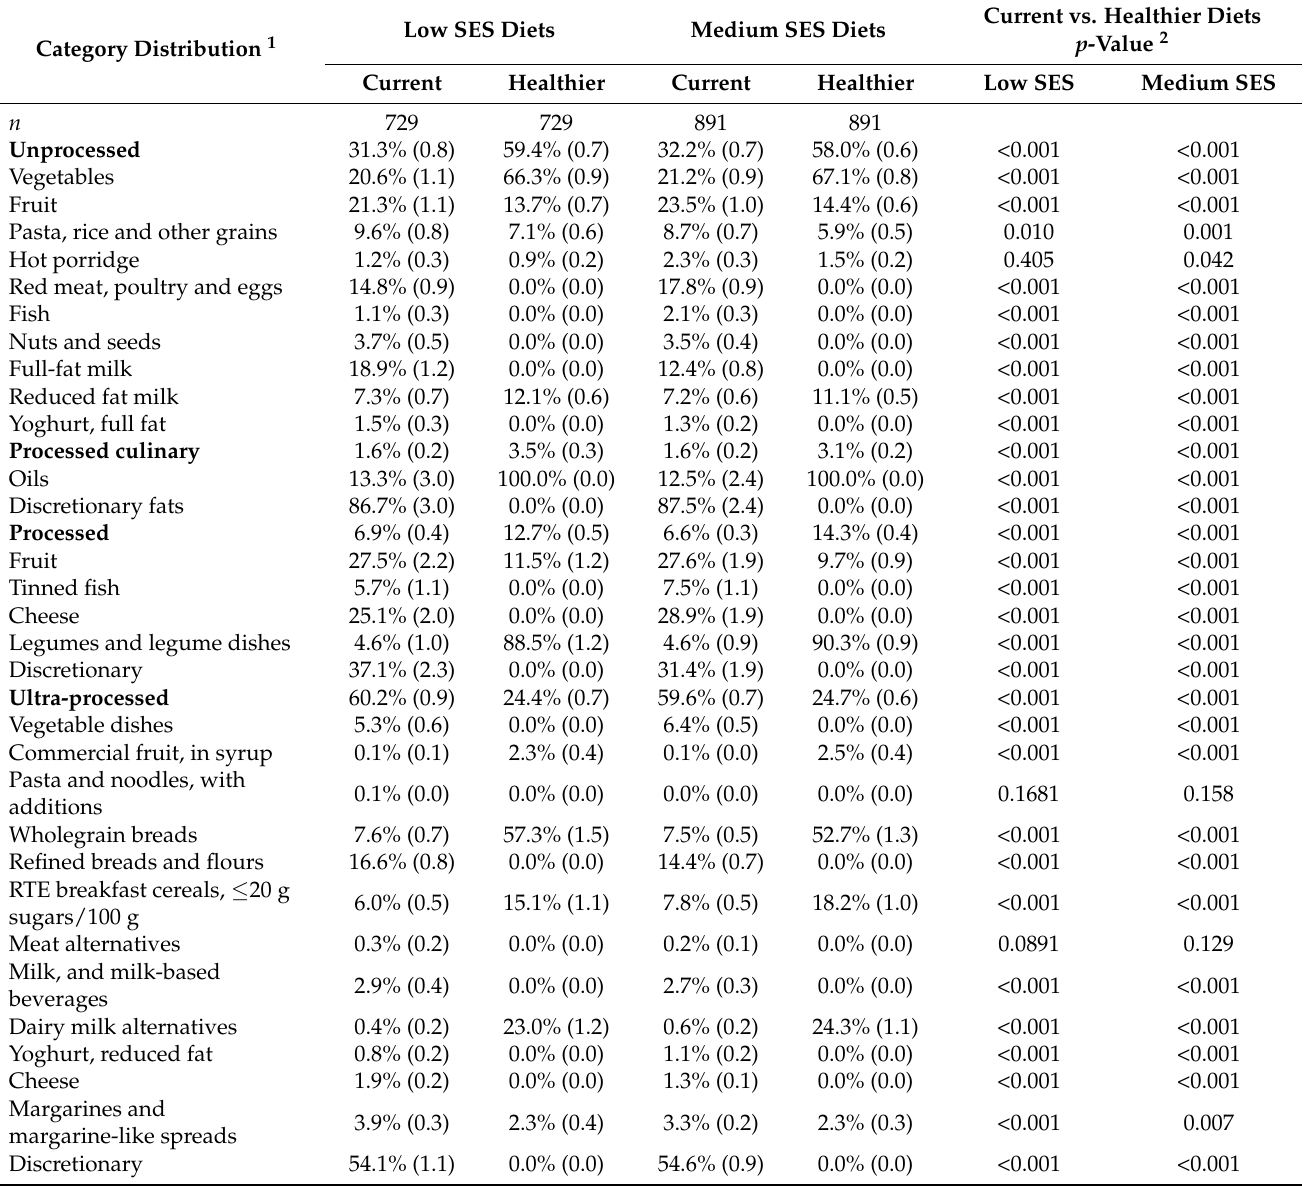
Table 6. Distribution of NOVA processing levels and food category types throughout the current and healthier diets for both low and medium SES